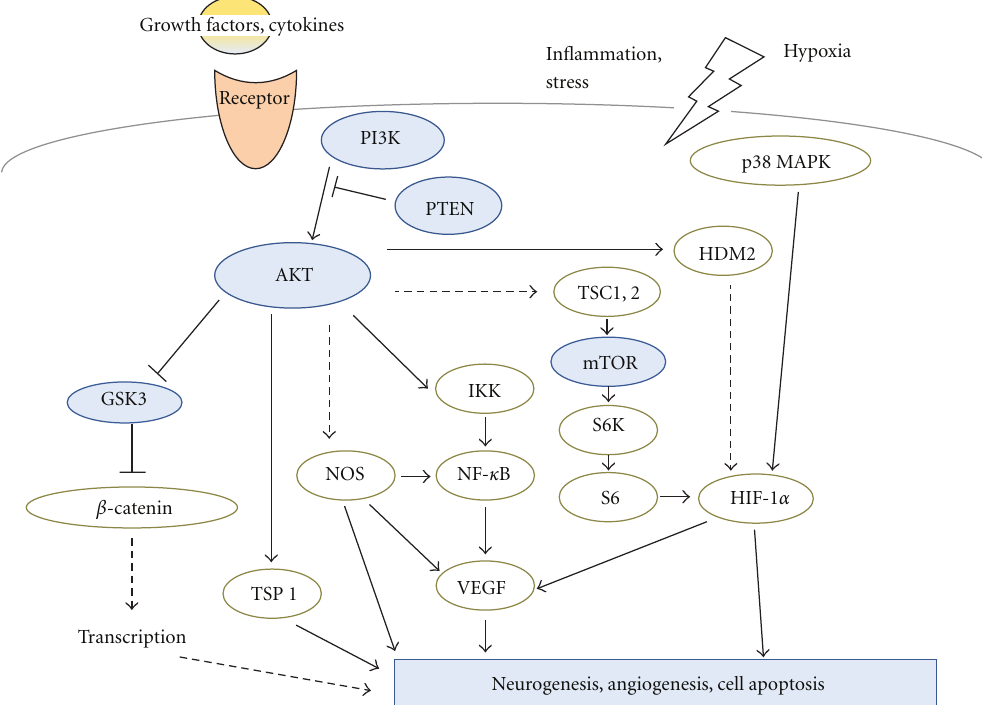
Figure 1: Schematic representation of PI3K/AKT/GSK3/mTOR signaling. Examples of molecules known to act on the regulatory pathways are shown. Note that some critical pathways have been omitted for